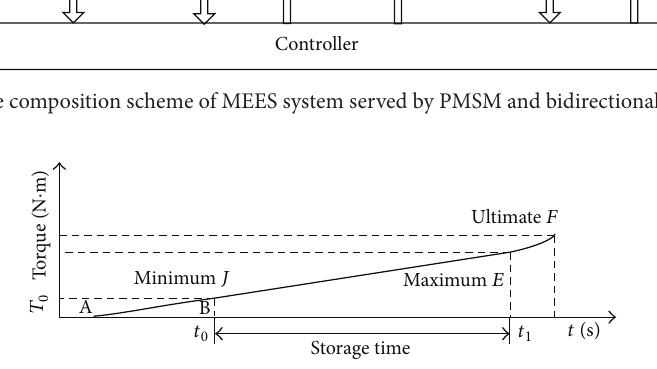
Figure 2: Characteristics curve for ES box in